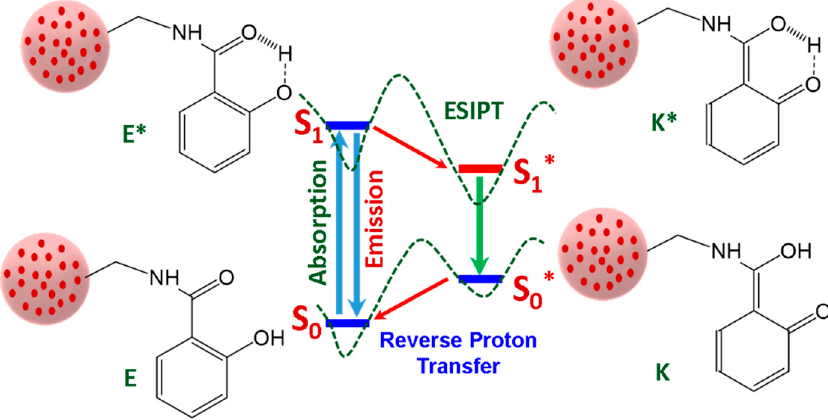
Figure 6. The schematic diagram for the intramolecular proton transfer (ESIPT) mechanism in salicylamide-immobilized ormosil nanosensor; E and K are the enol and keto tautomer species, respectively. The asterisk sign indicates the excited state.